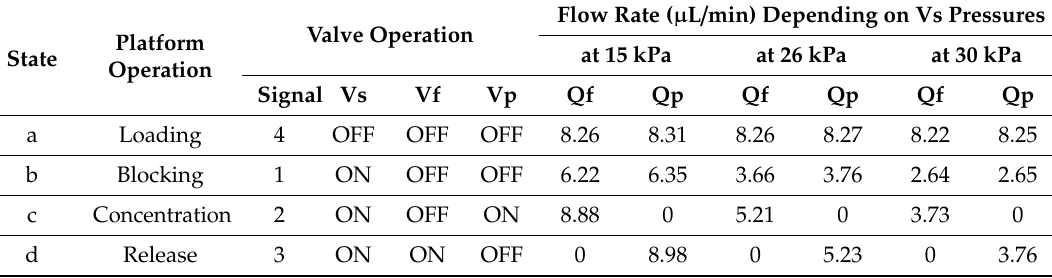
Figure 7. The working fluid flow rate over time as particles became concentrated by the microfluidic platform (a–d show that the positions of the pneumatic valves changed). ( a ) Vs at 15 kPa, ( b ) 26 kPa, ( c ) 30 kPa. Table 2. Particle concentration by pneumatic valves.